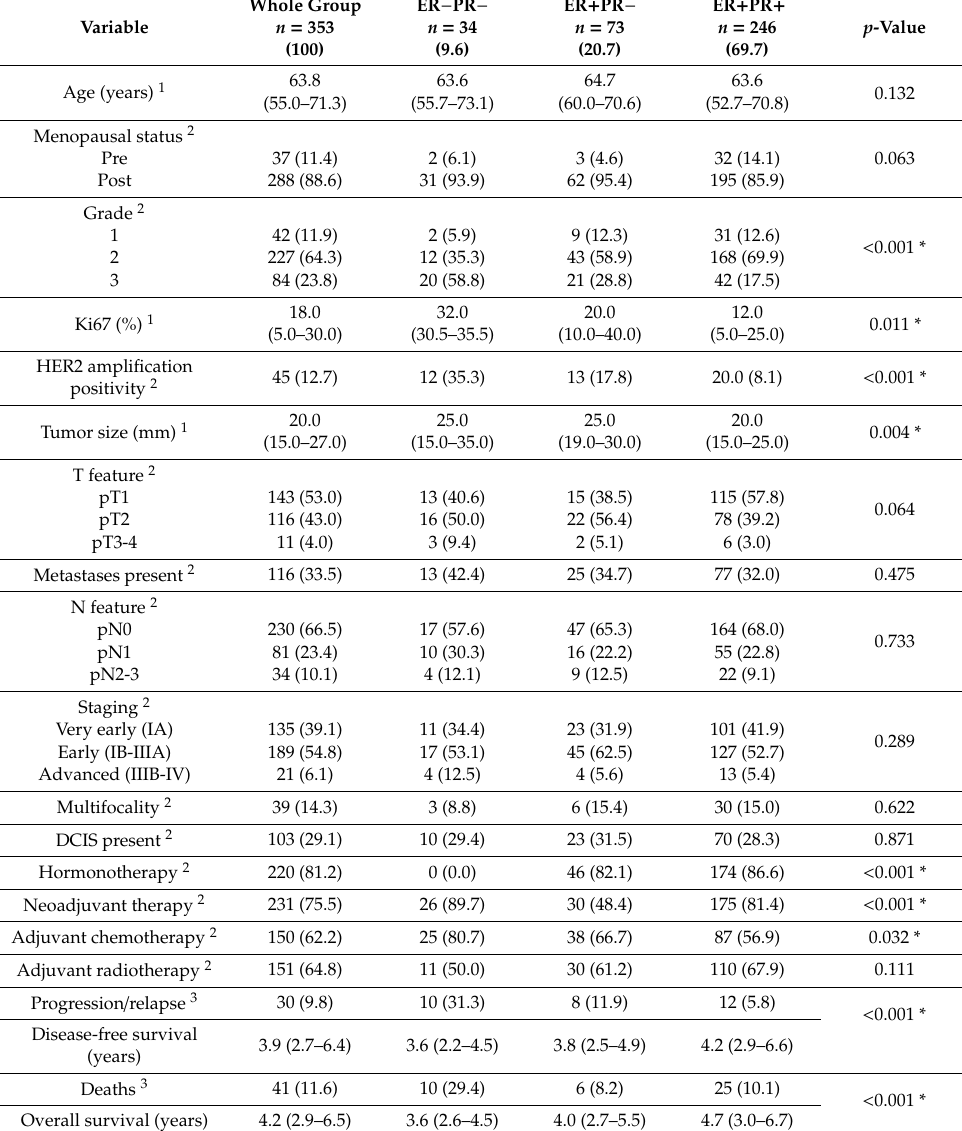
Table 1. Pathological and clinical characteristics of the study group regarding immunohistochemistry -based hormonal receptor status. Nominal variables are presented as raw values followed by percentages of the eligible groups, and continuous variables are presented as medians and interquartile ranges in